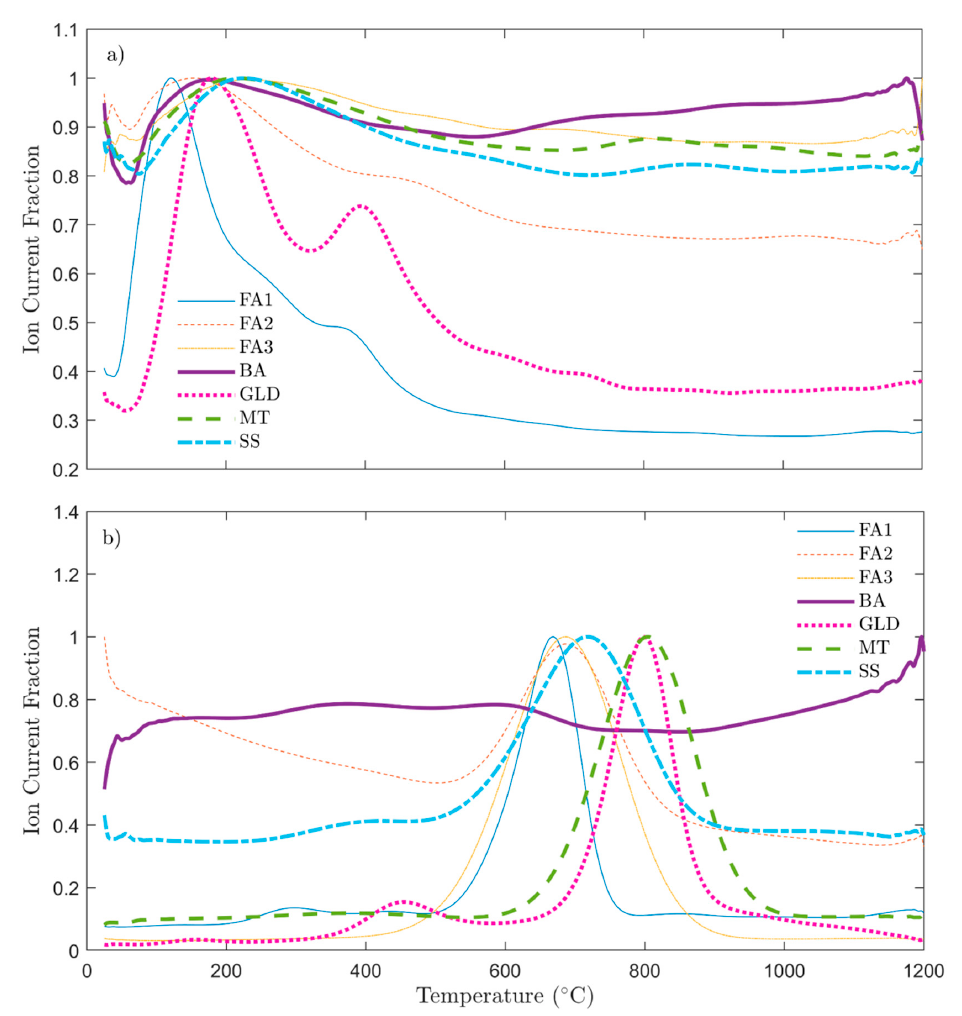
Figure 5. Normalised MS curves of the samples: ( a ) m/z =18 line (H 2 O), ( b ) m/z = 44 line (CO 2 ), FA1 (biomass fly ash 1), FA2 (biomass fly ash 2), FA3 (coal fly ash), BA (bottom ash), GLD (green liquor dregs), MT (coarse limestone tailings) and SS (steel slag).